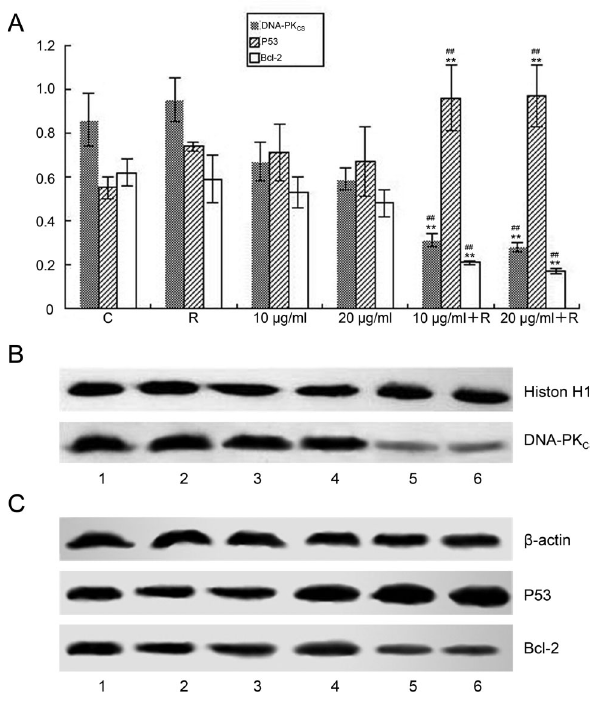
Figure 4 - Western blot analysis of the protein levels of Bcl-2, p53 and DNA-PKcs. A549 cells were irradiated with 4 Gy X-rays following treatment with 10 or 20 m g/mL elemene for 24 h. Proteins were extracted and separated by SDS-PAGE. (A) Levels of Bcl-2, p53 and DNA-PKcs were quantitated by densitometry, and the ratios of the three proteins are displayed. Values represent the mean ± SD, n=3, ** p o 0.01 compared to the control, ## p o 0.01 compared to radiation alone. Elemene inhibited the protein expression of (B) DNA-PKcs and (C) Bcl-2 and promoted the protein expression of p53. Key: 1, Control; 2, irradiation;